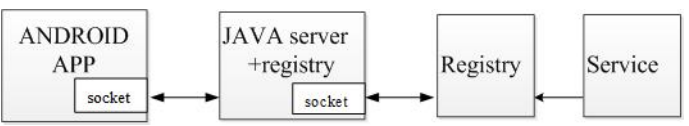
Figure 6. The whole process for the web service in